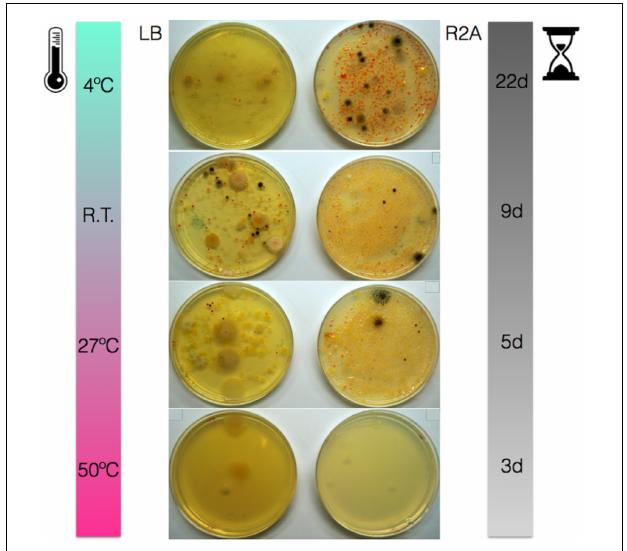
FIGURE 1 | Solar panel samples grown on LB and R2A media and incubated at 4 ◦ C, room temperature (22 ◦ C), 27 and 50 ◦ C for 22, 9, 5, and 3 days,